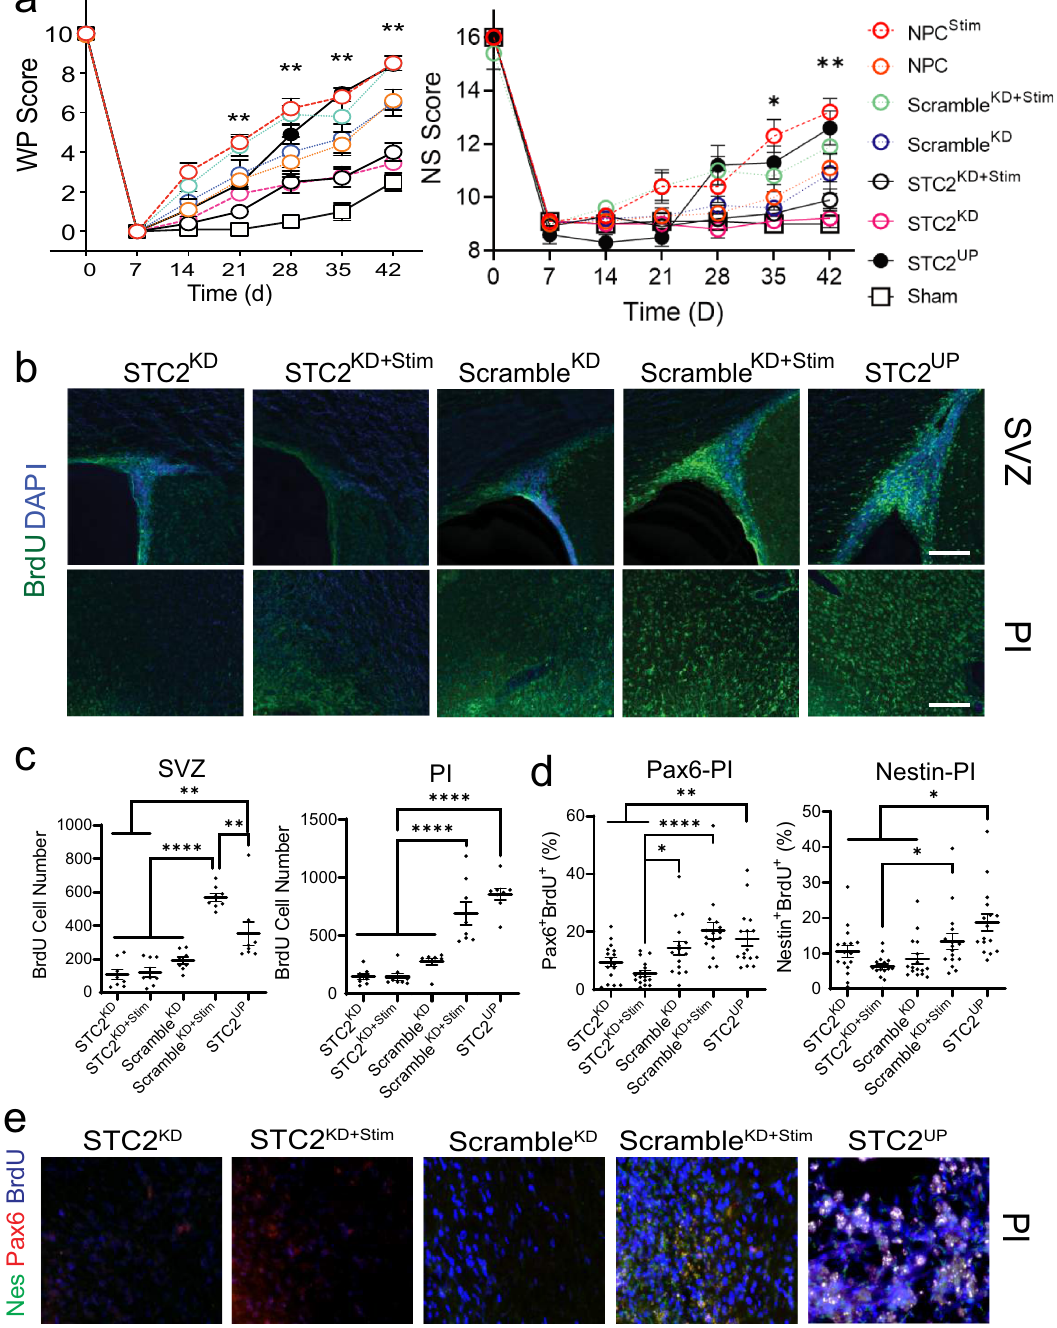
Fig. 4 STC2 is integral for improved stroke recovery. a Vibrissae-forepaw (WP) and total neurological score (NS). There is a statistically signi fi cant difference in NPC Stim , STC2 UP , and Scramble KD + Stim groups versus all other groups starting at week 3 and onward for WP Scores and week 5 and onward for NS scores. STC2 KD and STC2 KD + Stim showed no signi fi cant behavioral recovery at any timepoint in either WP Scores or NS Scores. b Representative images of fl uorescently labeled cells. Green indicates BrdU positive cells, whereas Blue indicates cell nucleus. Scale bar indicates 200 µ m. c BrdU positive cells in certain areas of interest. Data are shown as mean ± SEM, n = 8 images/4 rats. d PAX6/BrdU or Nestin/BrdU positive cells in certain areas of interest. Data are shown as mean ± SEM, n = 16 images/4 rats. e Representative images of fl uorescently labeled cells. Green indicates Nestin positive cells whereas Red indicates PAX6 positive cells. Blue indicates BrdU positive cells. Scale bar indicates 200 µ m. a Analyzed using a Kruskal – Wallis test followed by post-hoc pairwise Mann – Whitney U test with Benjamini – Hochberg correction to control the false discovery rate at the 0.05 level. For both, * P < 0.01, ** P < 0.001, data shown as mean ± SEM, n = 10 per group. c , d Analyzed using a one-way ANOVA, followed by Tukey ’ s HSD post-hoc test with * P < 0.05, ** P < 0.01, and **** P <